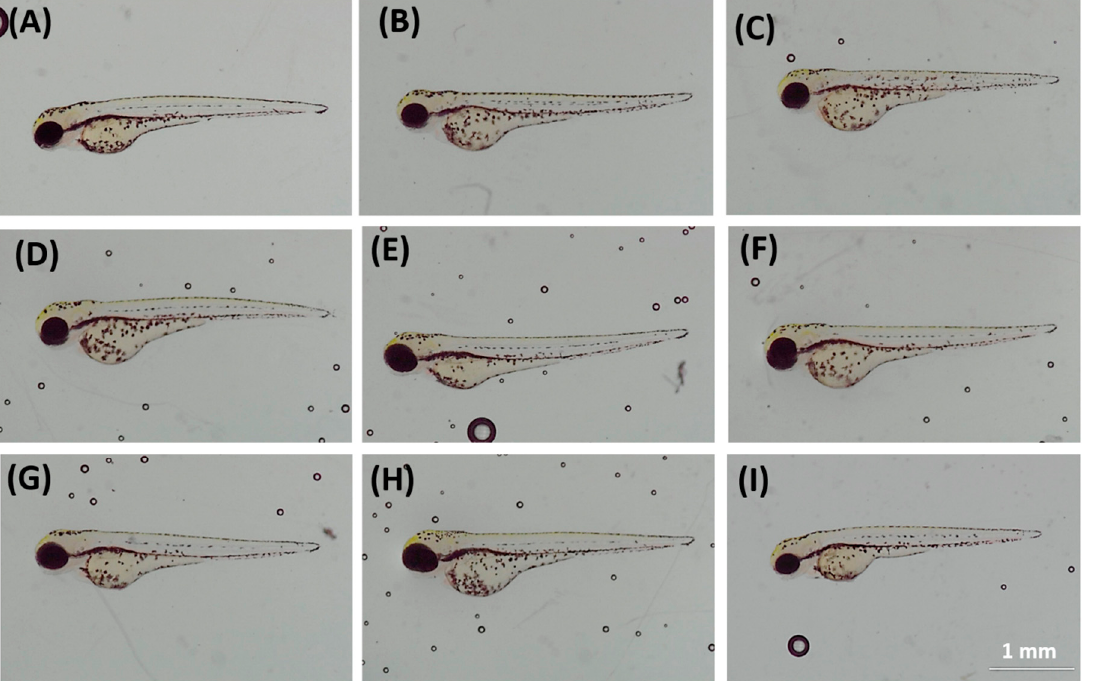
Figure A1. Zebrafish morphology after 12 h incubation at highest environmental relevant concentration (100 ppb) of ( A ) acesulfame-K, ( B ) Alitame, ( C ) Aspartame, ( D ) Dulcin, ( E ) Neotame, ( F ) Saccharine, ( G ) Sodium Cyclamate, ( H ) Sucralose, and ( I ) distilled water. (scale bar = 1 mm).